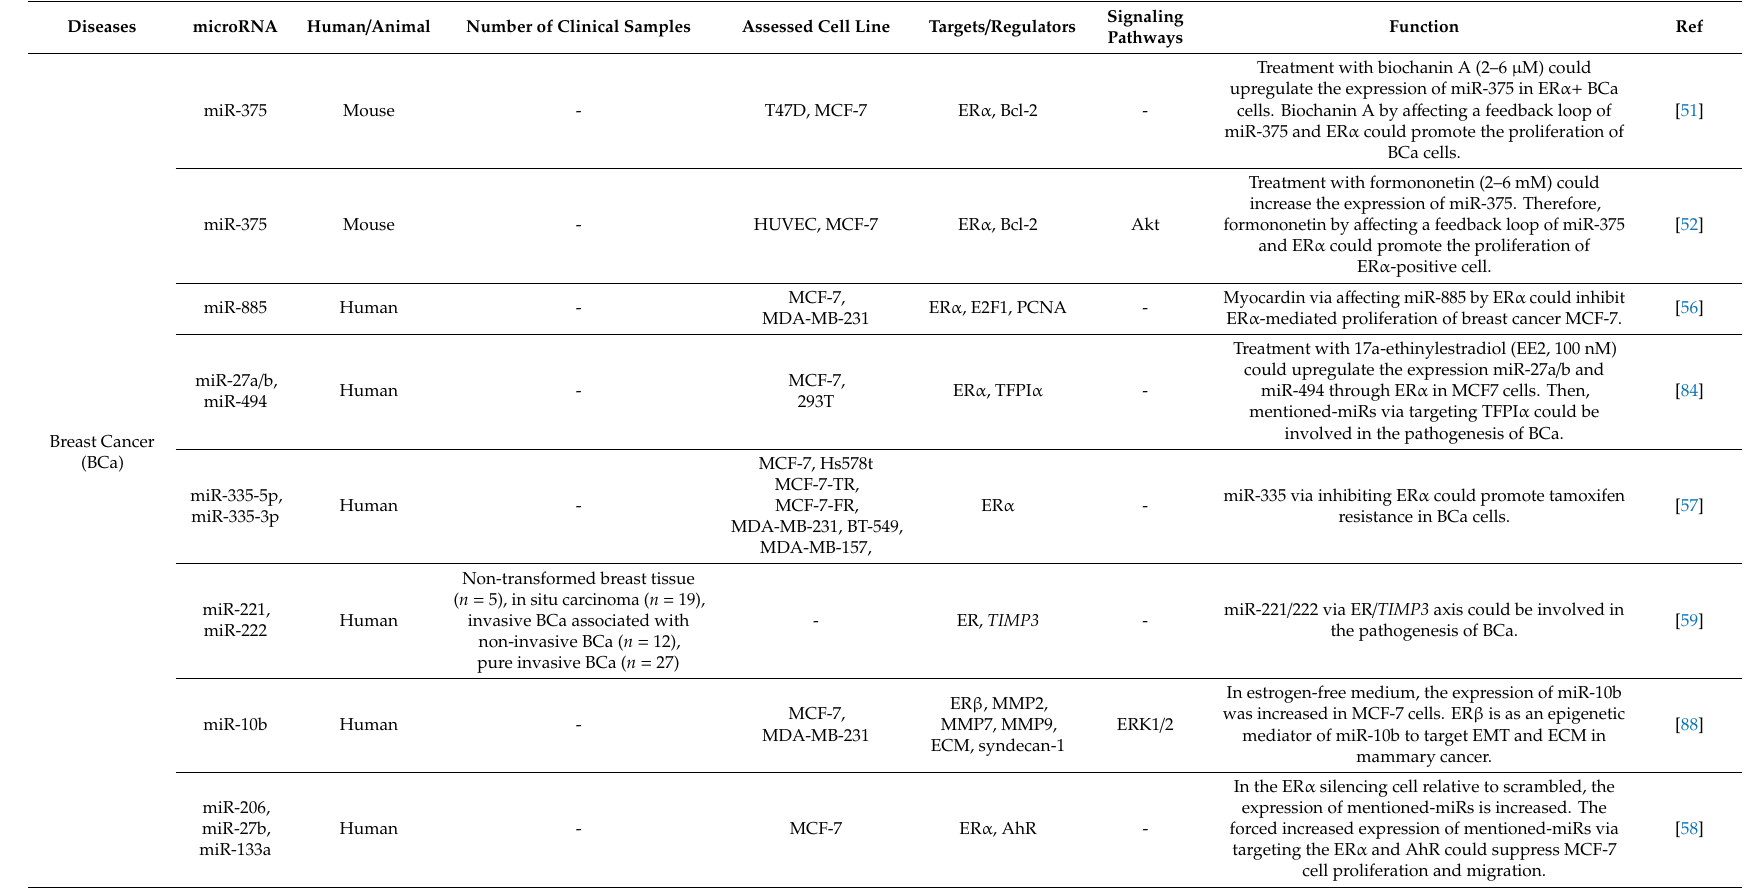
Table 2. List of upregulated ER-associated miRNAs in